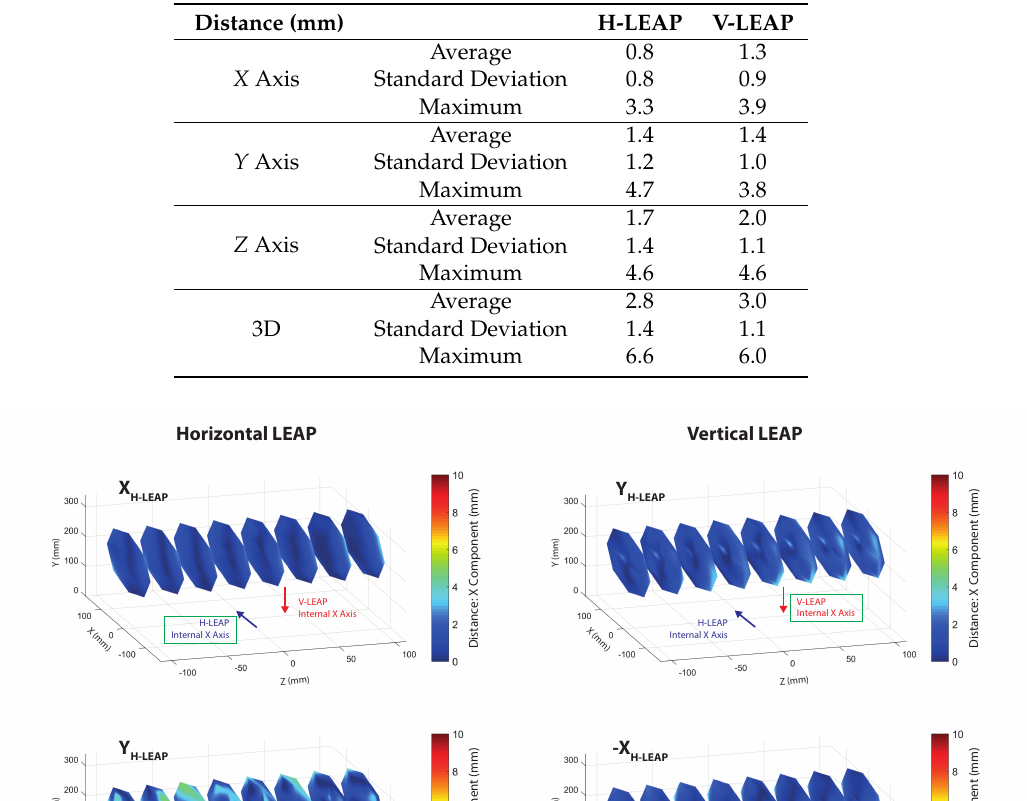
Table 1. Average, standard deviation and maximum value of the distance, in mm, along each axis and in the space, of data reported in Figure 5.